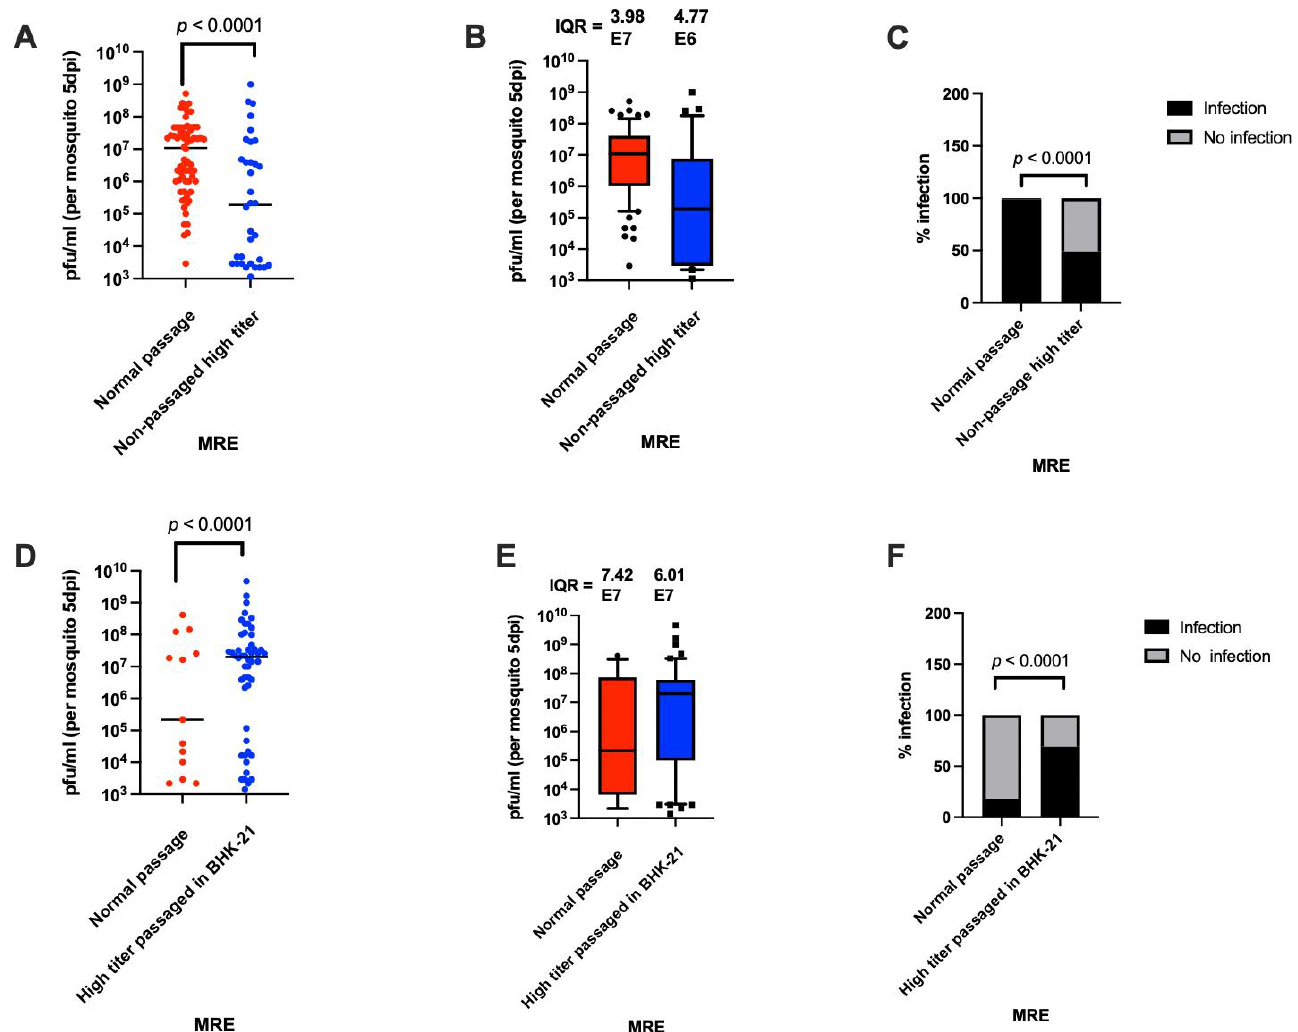
Figure 7. Refeeding experiment using viruses obtained from a single high titer mosquito, either passaged once in BHK-21 cells or not passaged. ( A ) Titers of mosquitoes at 5 days PBM after oral infection with virus (2.0 × 10 9 PFU/mL) from high titer mosquitoes compared to stock MRE-16 virus. ( B ) The use of IQR as a measure of variation. The data used in panel B are the same as in A. Sample size was 72 per treatment. ( C ) Prevalence of infection after oral infection with virus from high titer mosquitoes versus stock MRE-16 virus. ( D ) Titers of mosquitoes at 5 days PBM that were orally infected using virus from high titer mosquitoes passaged once in BHK-21 cells versus MRE-16 stock virus (1 × 10 6 PFU/mL). ( E ) The use of IQR as a measure of variation. The data used in panel ( E ) are the same as in ( D ). ( F ) Prevalence of oral infection after exposure to virus from high titer mosquitoes passaged once in BHK-21 cells versus stock MRE-16 virus. Sample size used was 72 per treatment. Statistical analysis was performed as described for Figure